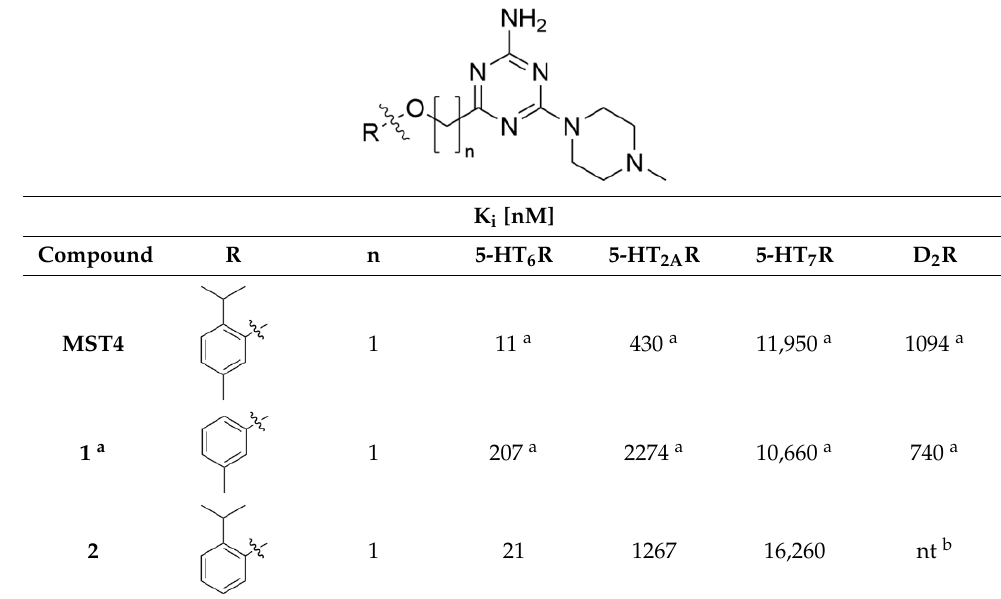
Table 1. Structures and biological activity of tested compounds 1 – 7 (series 1). 1